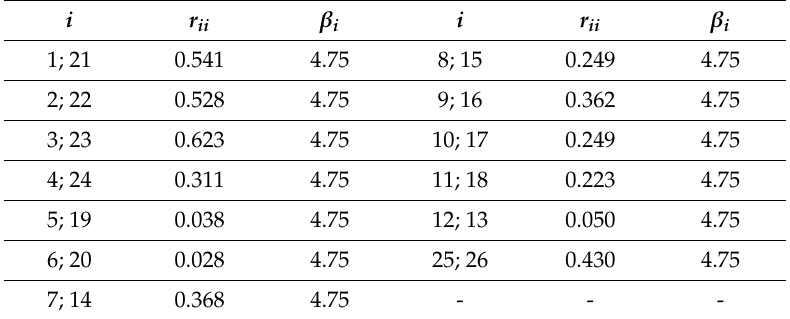
Table 2. Redundancy contributions ( r ii ) and reliability indexes ( β i ) for components of variant 1.